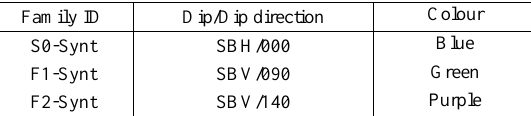
Table 1. Orientation of three discontinuity families for the